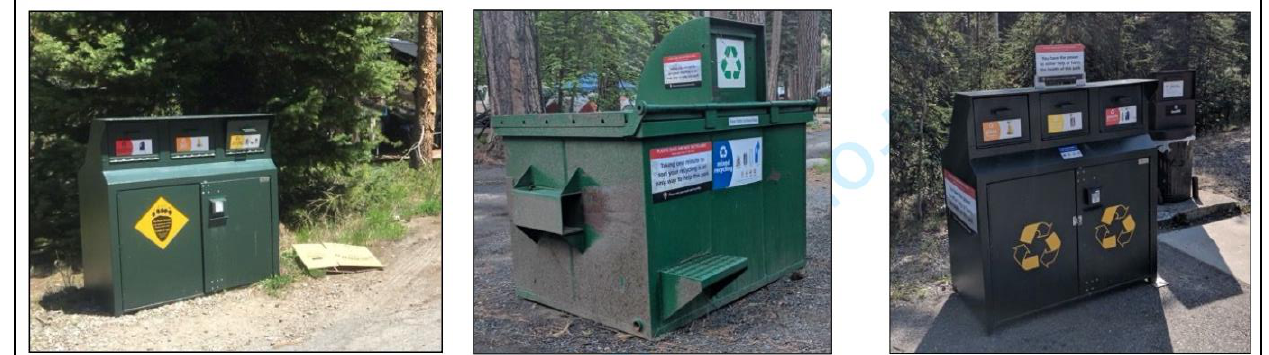
Figure 3. Examples of control and treatment conditions at National Park campground waste infra- structure (right to left, Control Condition Example, Ease Condition Example —“Taking one minute to sort your recycling is an easy way to help this park.”, Moral Norms Condition Example—“You have the power to either help or harm the health of this park.”).